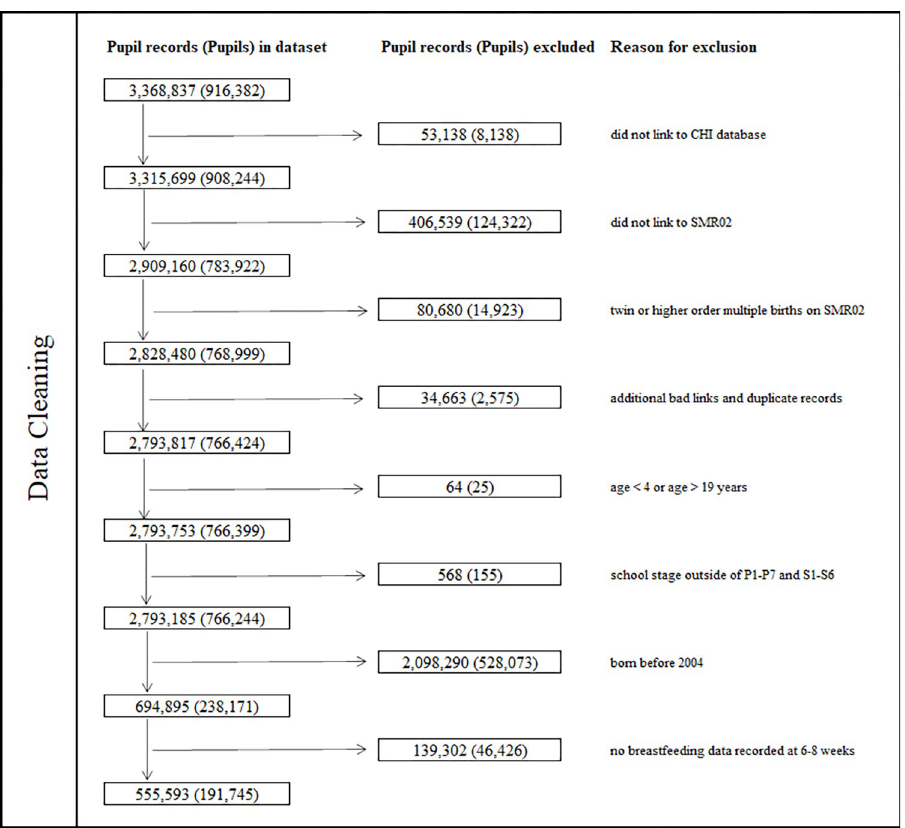
Fig 1. Flow diagram presenting the number of records and pupils excluded at each stage of data cleaning. CHI, Community Health Index; P1–P7 primary 1 through primary 7; SMR, Scottish Morbidity Record; S1–S6, secondary 1 through secondary